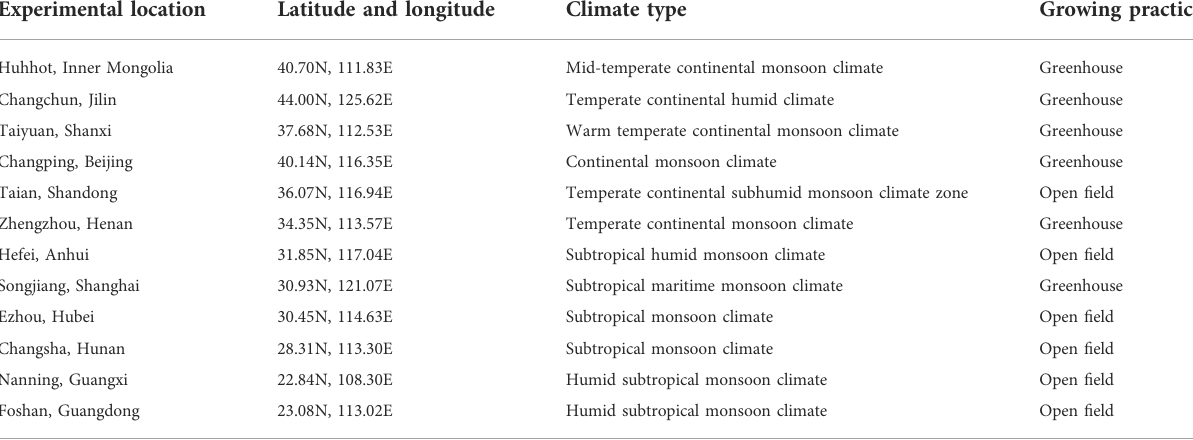
TABLE 1 Latitude and longitude, climate type, and growing practices of 12 sites. Experimental